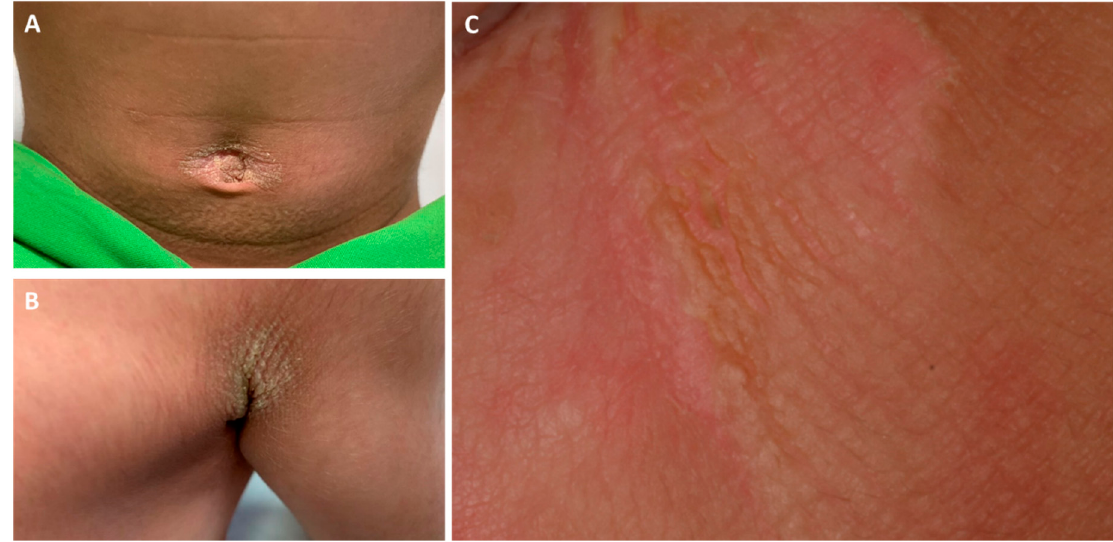
Figure 1. Clinical pictures of the umbilical ( A ) and axillar ( B ) regions of the proband. The gluteal region ( C ) showed a marked hyperkeratotic plaque with mild epidermolysis, fissures and lichenification.